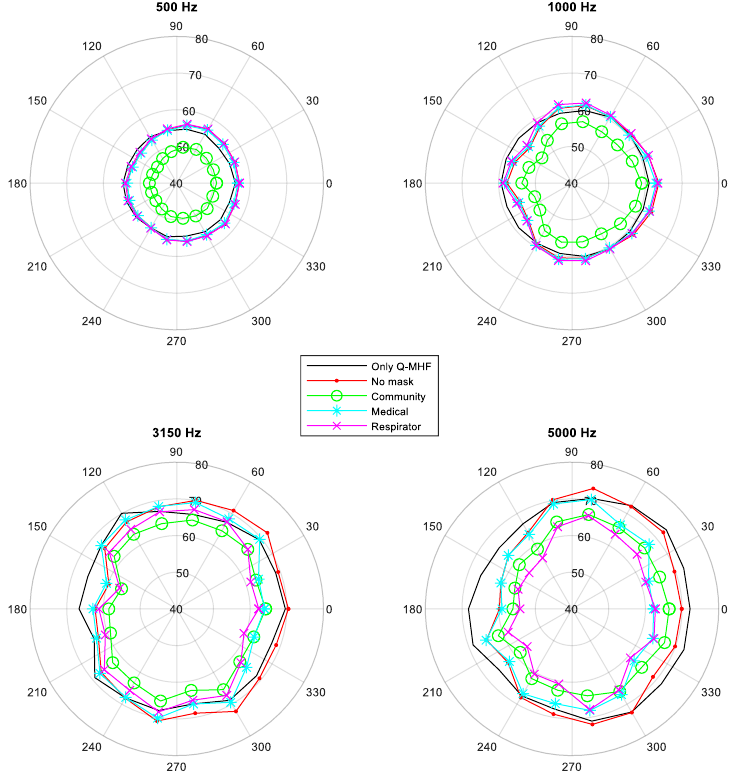
Figure 6. Acoustic pressure 1/3 octave bands directivity plots in dB(Z). The decibel reference is 20 μPa. Radial scale between 40 and 80 dB(Z).